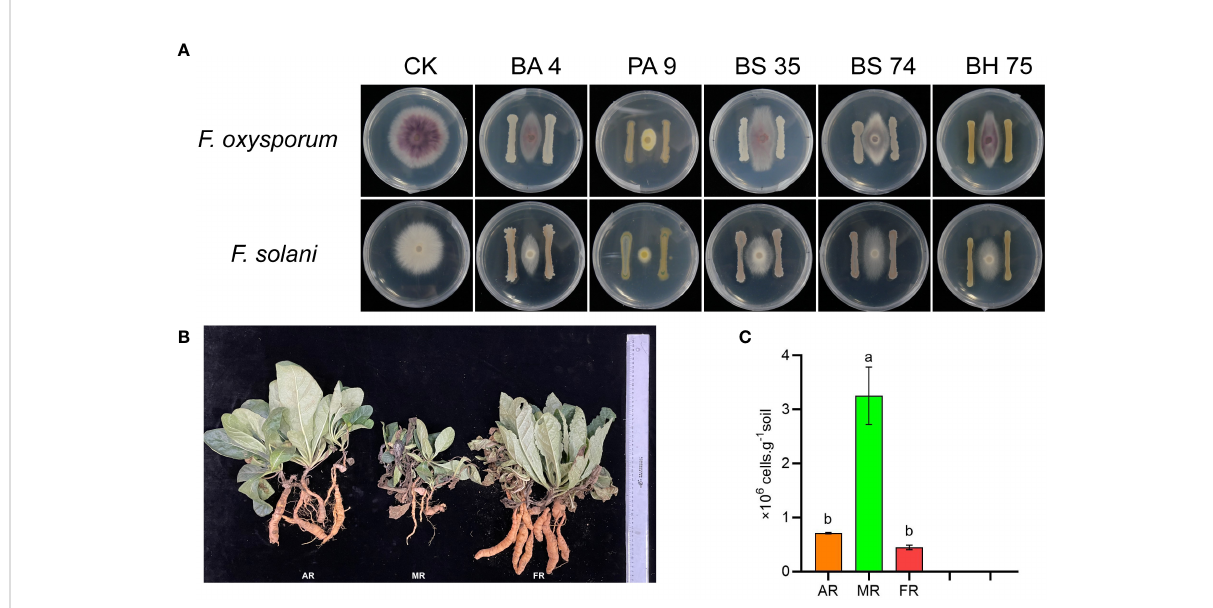
FIGURE 8 Functional veri fi cation of species microbe in vitro interaction. (A) means effect of different bacteria against the pathogenic fungi of R. glutinosa . PA 9 means Pseudomonas aeruginosa 9, BA 4 means Bacillus amyloliquefaciens 4, BS 35 means Bacillus subtilis 35, BS 74 means Bacillus subtilis 74, BS 75 means Bacillus halotolerans 75. (B) means growth of R. glutinosa under different treatments. AR means add the mix bacterial agent R. glutinosa , MR means monoculture R. glutinosa , and FR means fi rst stubble R. glutinosa. The number of Fusarium in rhizosphere soil under each treatment (C) . Different letters in columns show signi fi cant differences determined by LSD ’ s test (p<0.05,